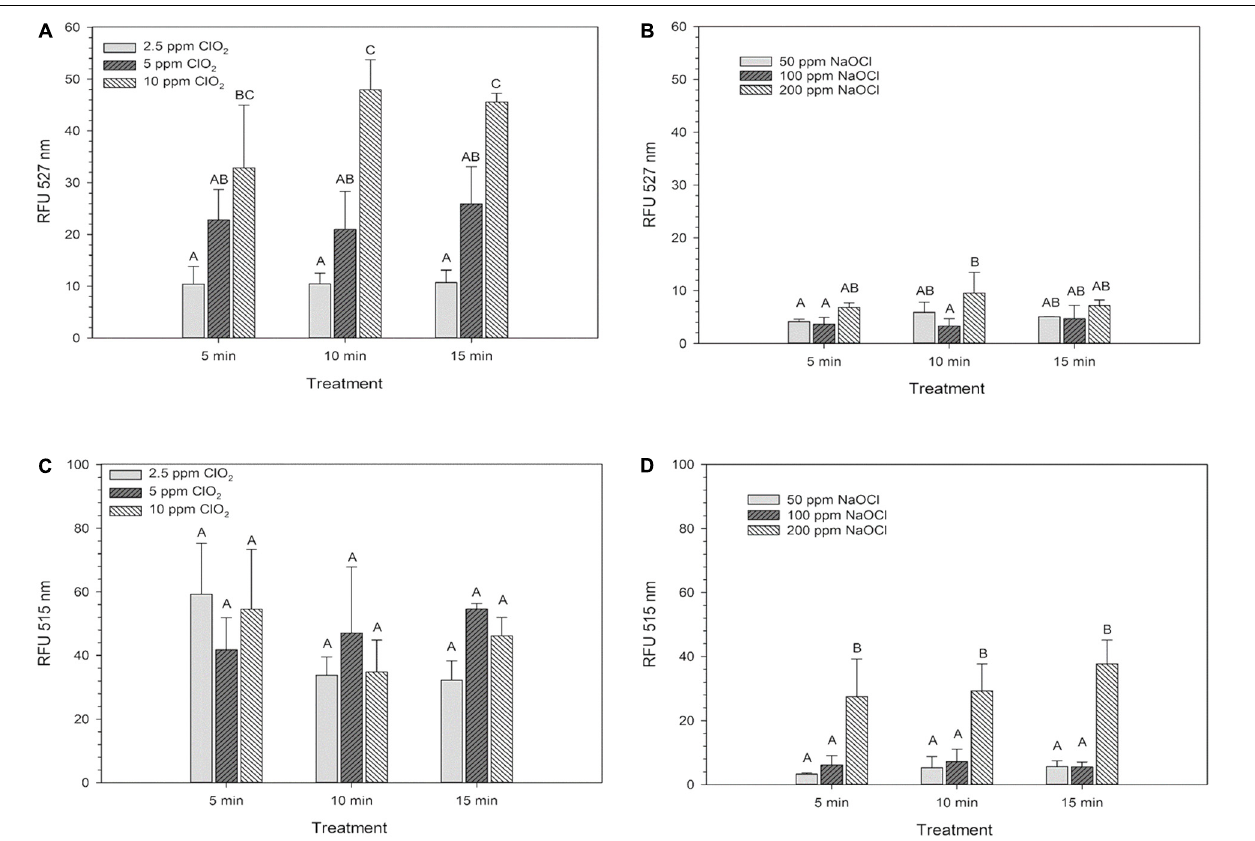
FIGURE 2 | Intracellular ROS of Escherichia coli O157:H7 measured by DCF-DA after treatment with ClO 2 (A) or NaClO (B) and the ROS levels as measured by APF after treatment with ClO 2 (C) or NaClO (D) . Data are presented as means ± standard deviations, and significant differences ( P ≤ 0.05) in relative fluorescence units (RFUs) observed after each treatment are represented by different letters (e.g.,